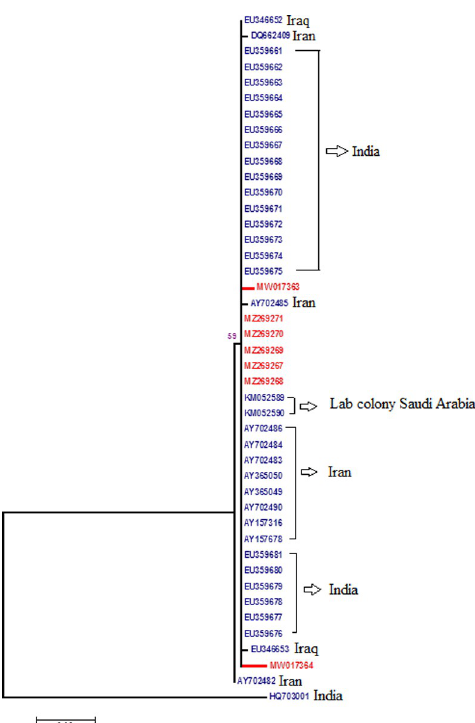
Fig 4. Phylogeny of rDNA-ITS2 sequences from lab strain. Bootstrap values > 70 shown at nodes. Nodes without numbers had a value < 70. Final ML Optimization Likelihood: -1104.708501.